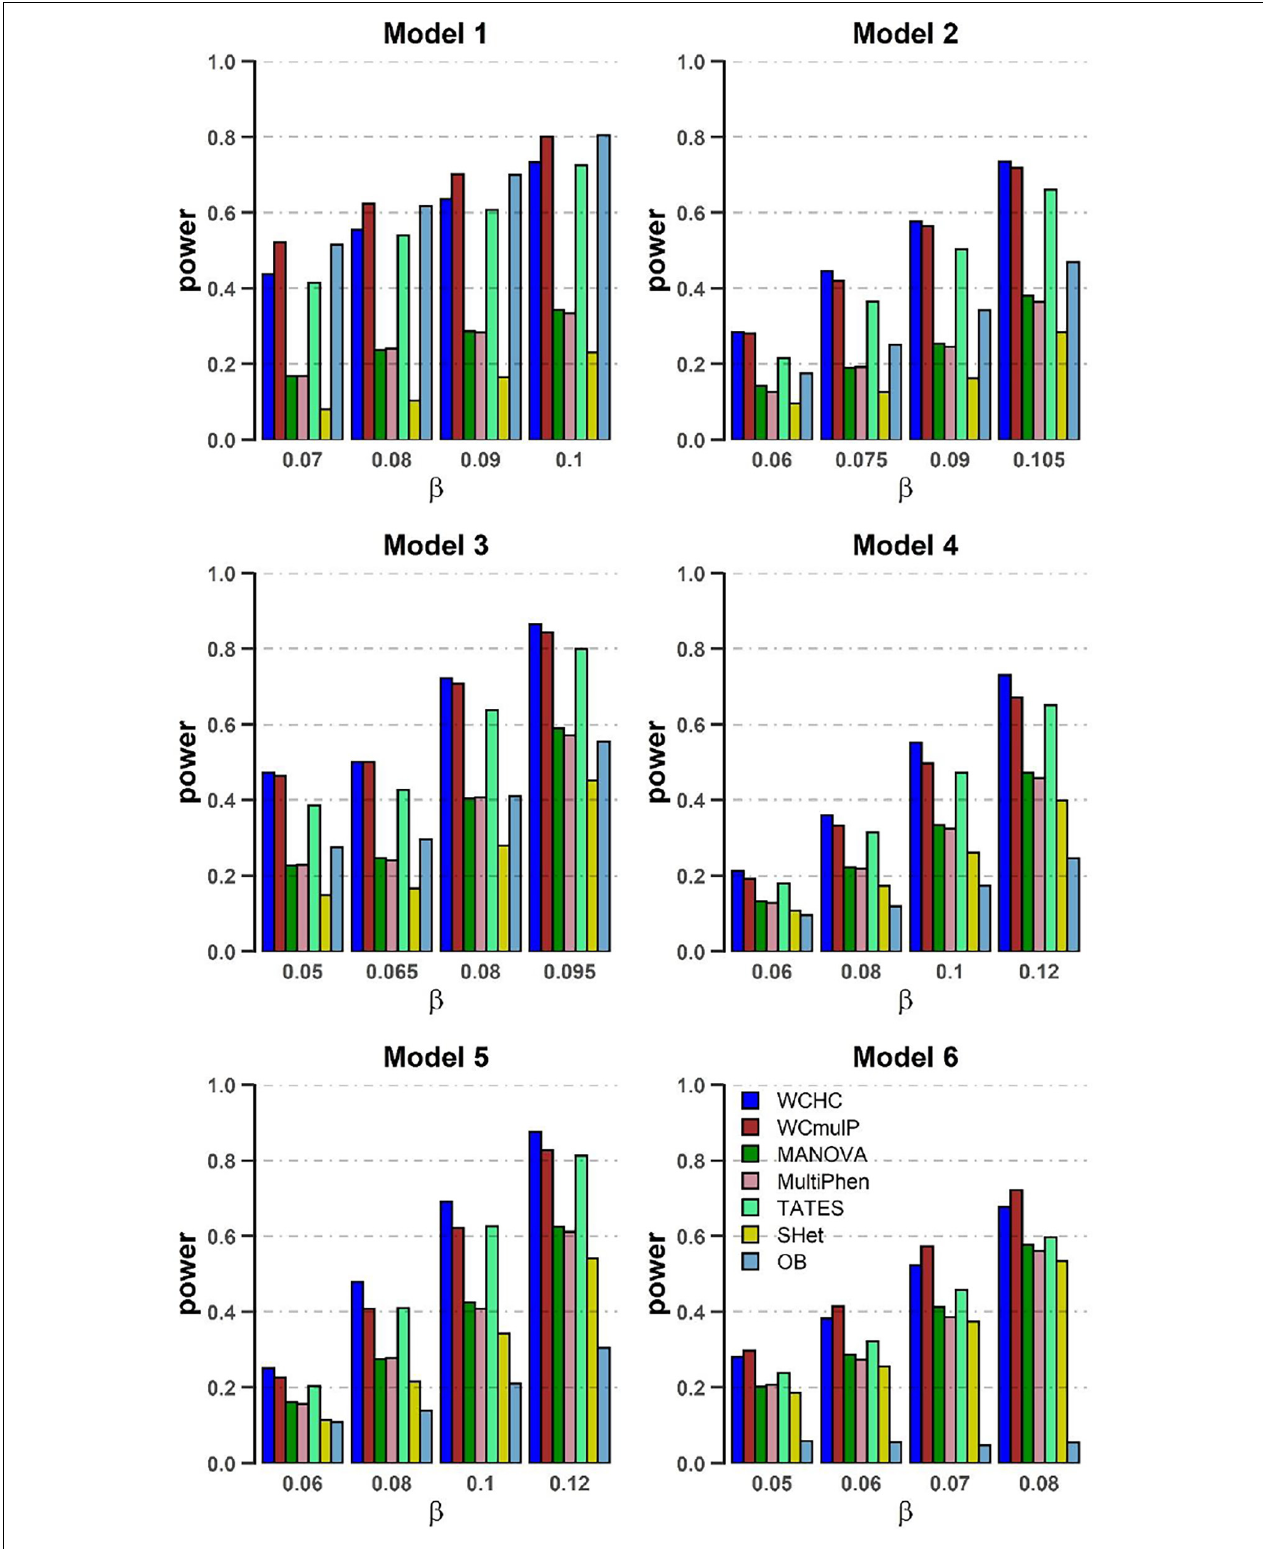
FIGURE 1 | Power comparisons of the seven methods as a function of β in the six models. Sample size is N = 1,000, the number of phenotypes is M = 16, c 2 = 0.5, ρ c 2 = 0.1, and MAF = 0.3. The power of all the seven methods is estimated by 1000 replicated samples at a significance level of 0.05.